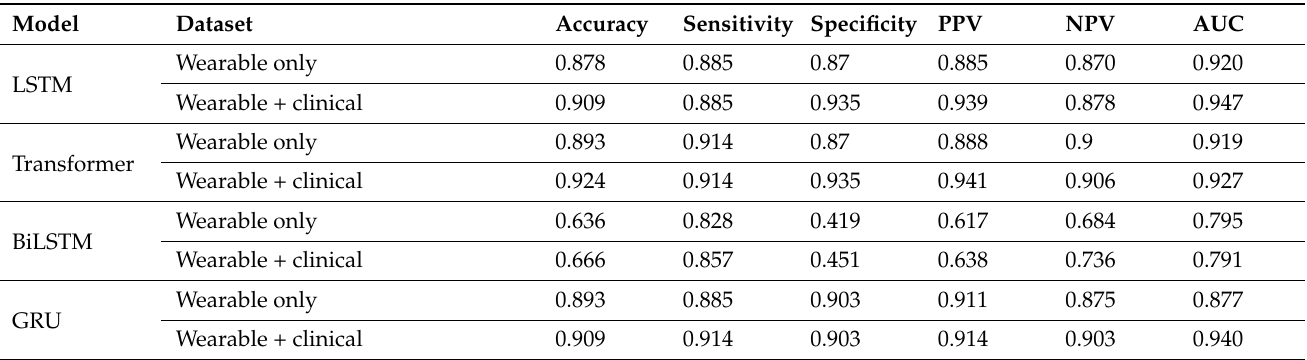
Table 2. Performances of different models using the wearable data and the combined data of wearable and clinical data from 48 h data.